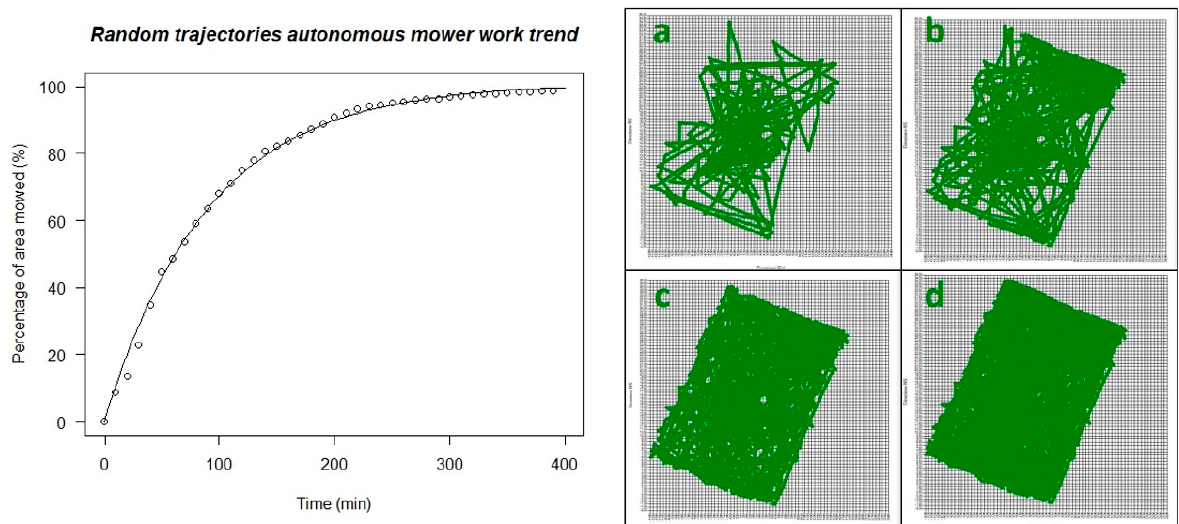
Figure 2. ( Left ) Data trend of mowed area percentage as a function of time (min) for the autonomous mower with random trajectories working on 600 m 2 : observed values averaged across 4 replications (dots) and regression curve (solid line). ( Right ) Custom-built software showing the mowed area on 2 September 2020 at different time intervals: ( a ) 60 min; ( b ) 150 min; ( c ) 240 min; ( d ) 390 min.